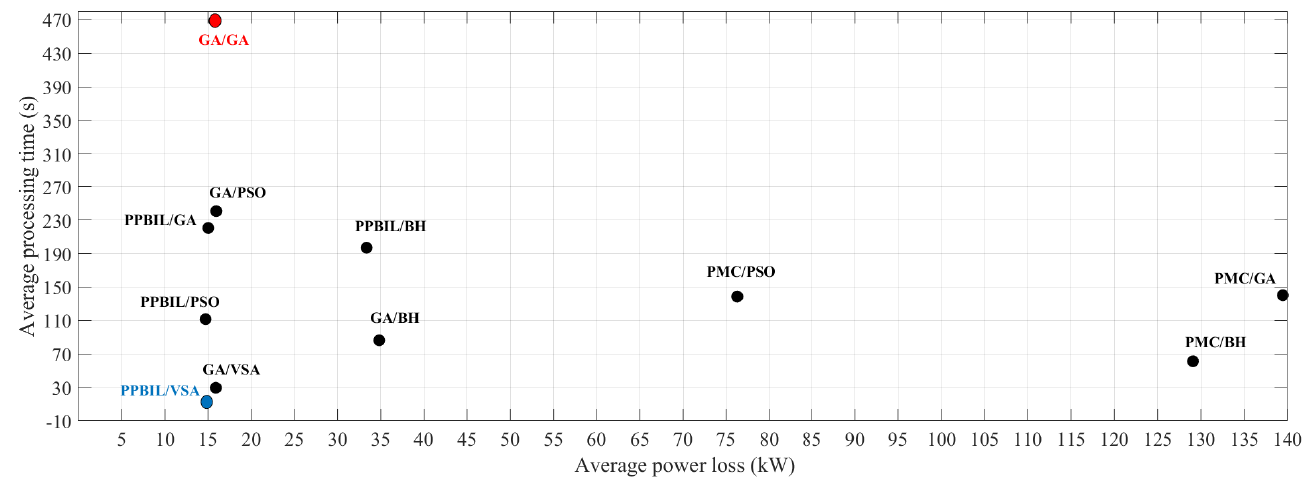
Figure 9. Trade-off between average power losses and required processing time provided by the hybrid methodologies in the 69-bus test